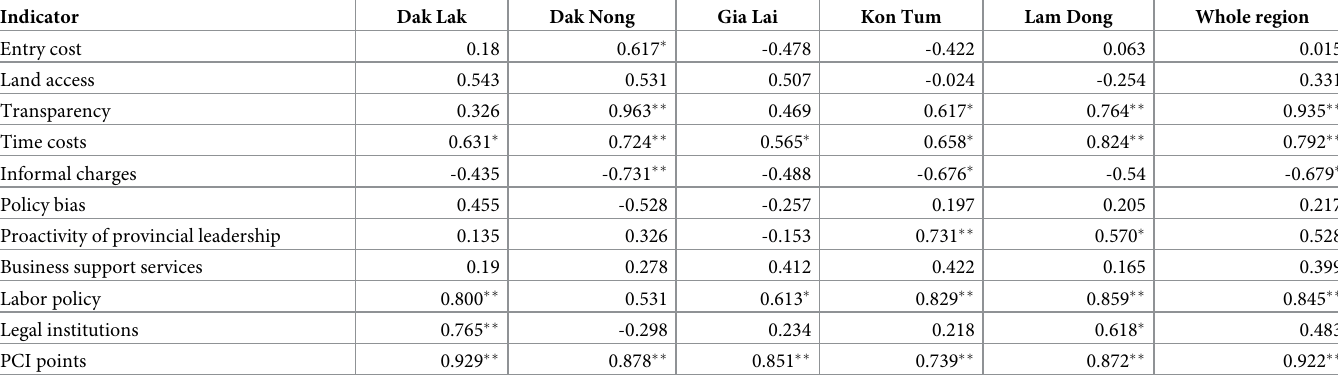
Table 7. Correlation between PCI and the capital of enterprises in the Central Highlands in the 2006–2018 period.